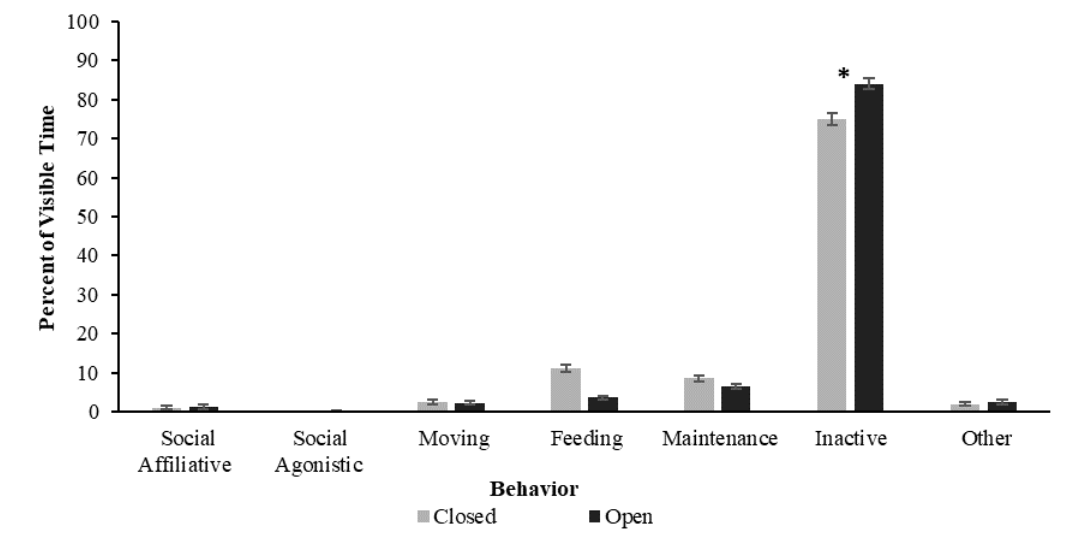
Percent ± SE of Visible Kangaroos Engaged in Each Behavior Between Zoo Status Conditions